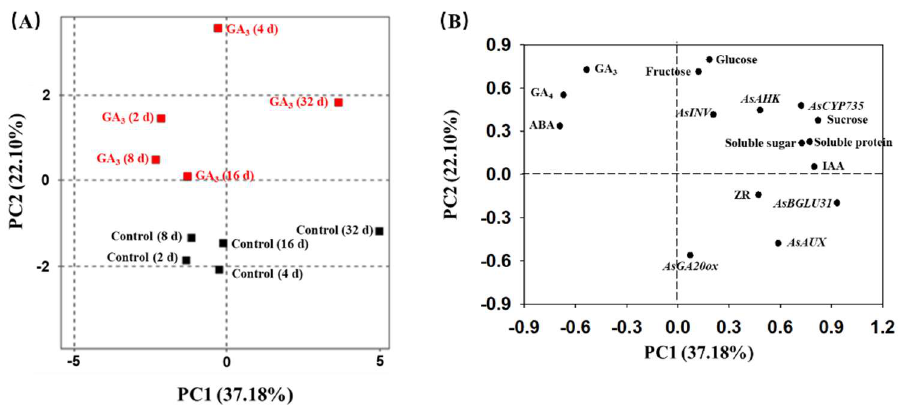
Figure 6. PCA ( A ) and ( B ) loading plots of principal components 1 and 2 obtained from phytohormone level, sugars content, soluble content and expression level of key genes in stems of GA 3 -treated plants and water-treated plants (control) at 2, 4, 8, 16 and 32